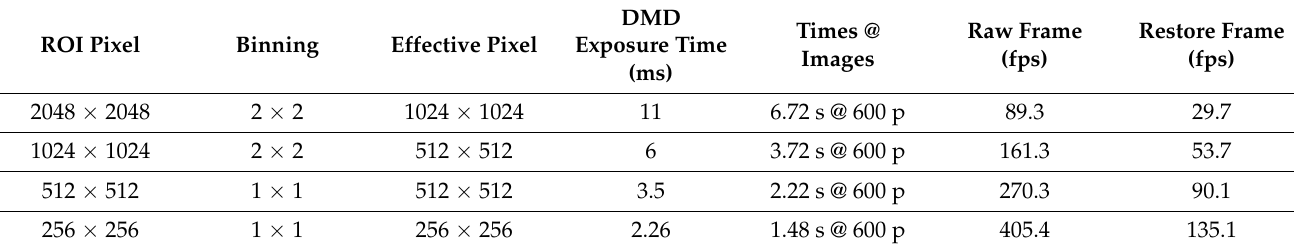
Table 1. Acquisition raw frame rate and one optical-sectioning SIM frame rate according to different ROIs. ROI Pixel Binning